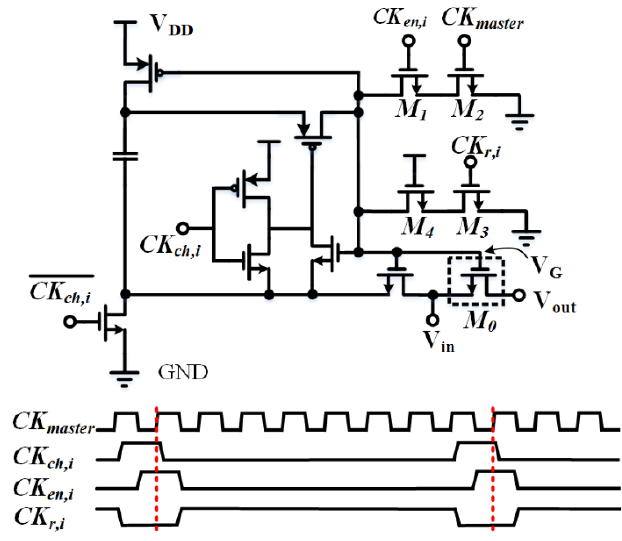
Figure 3. Channel-selection-embedded bootstrap switch.